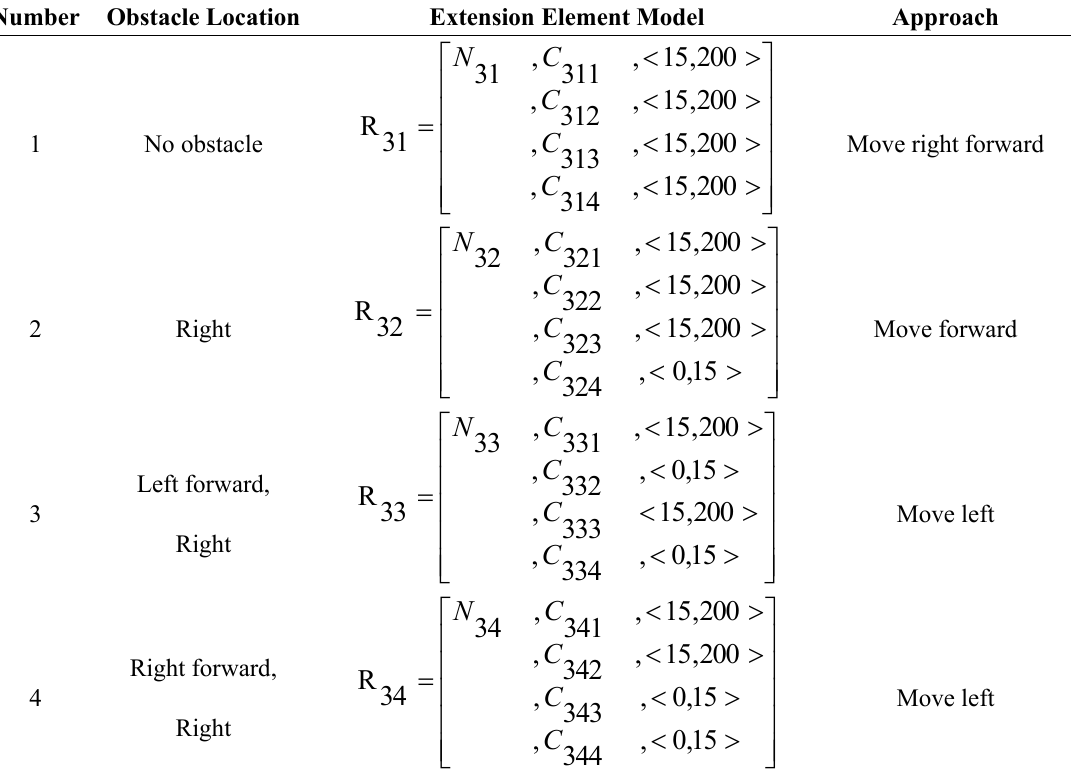
Table 4. Rule table for right forward motion in the extension-element